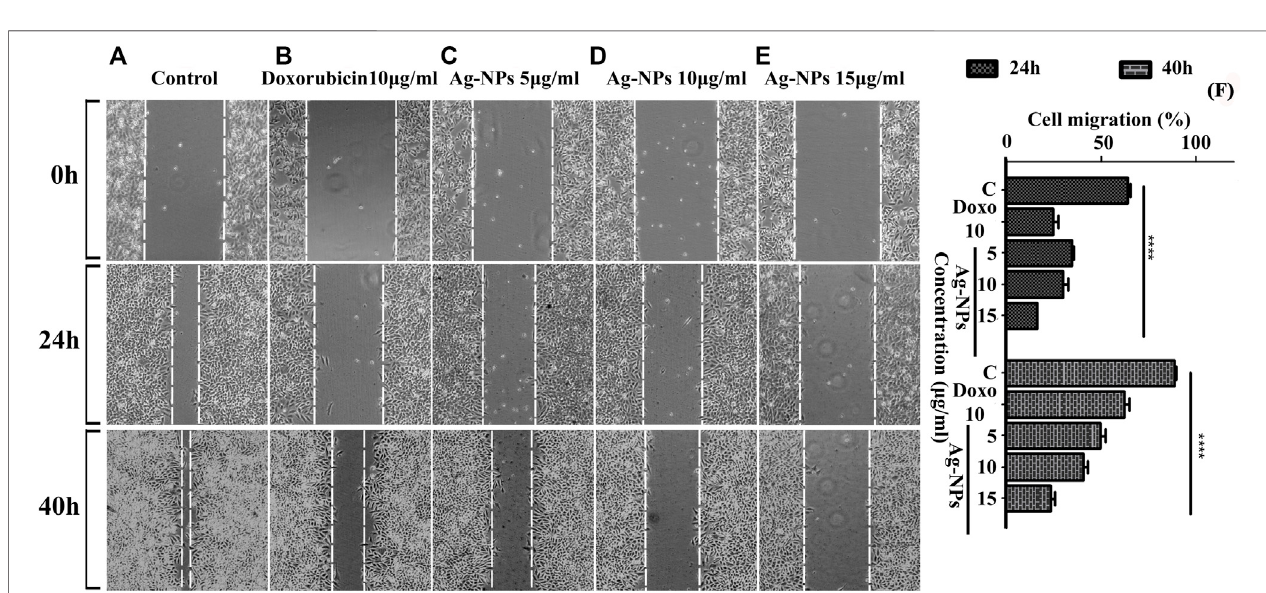
FIGURE7|(A – F) MicrographsshowingthemeasurementofscratchedcellmigrationintheabsenceorpresenceofAg-NPsposttreatmentfor24and40 hinHeLa cell lines. (A) Control at 0, 24, and 40 h, (B) doxorubicin 10 μ g/ml, (C) 5 μ g/ml Ag-NPs, (D) 10 μ g/ml Ag-NPs and (E) 15 μ g/ml Ag-NPs. (F) The rate of wound healing wasevaluatedbydifferencesofcells fi llingthescratchedarea( p < 0.05)inHeLacellsinthreebiologicalreplicatesforeachtreatmentandcontrolgroupbasedontwo-way ANOVA followed by Tukey ’ s test. Values are represented as mean % of cell migration of three replicates.